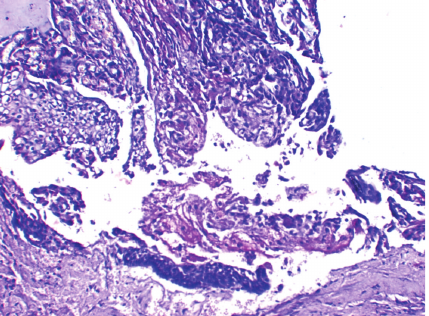
Figure 10: Photomicrograph of the lesion showing mucus cells (mucicarmine positive), clear cells, and intermediate cells (H&E, 10x).